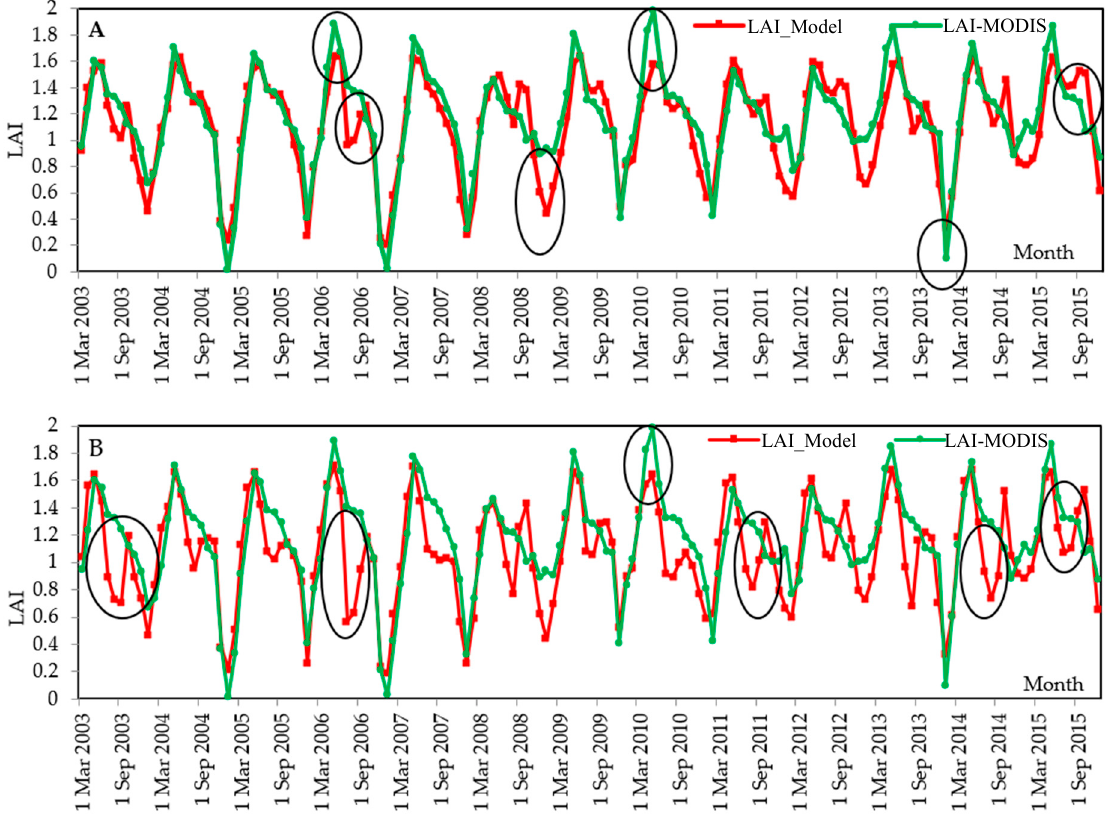
Figure 6. Time series of the spatially-averaged MODIS LAI vs. simulated LAI, ( A ) LAI model Equation (9) with rainfall interpolated with Kriging; ( B ) LAI model Equation (10) with rainfall interpolated with WLS.